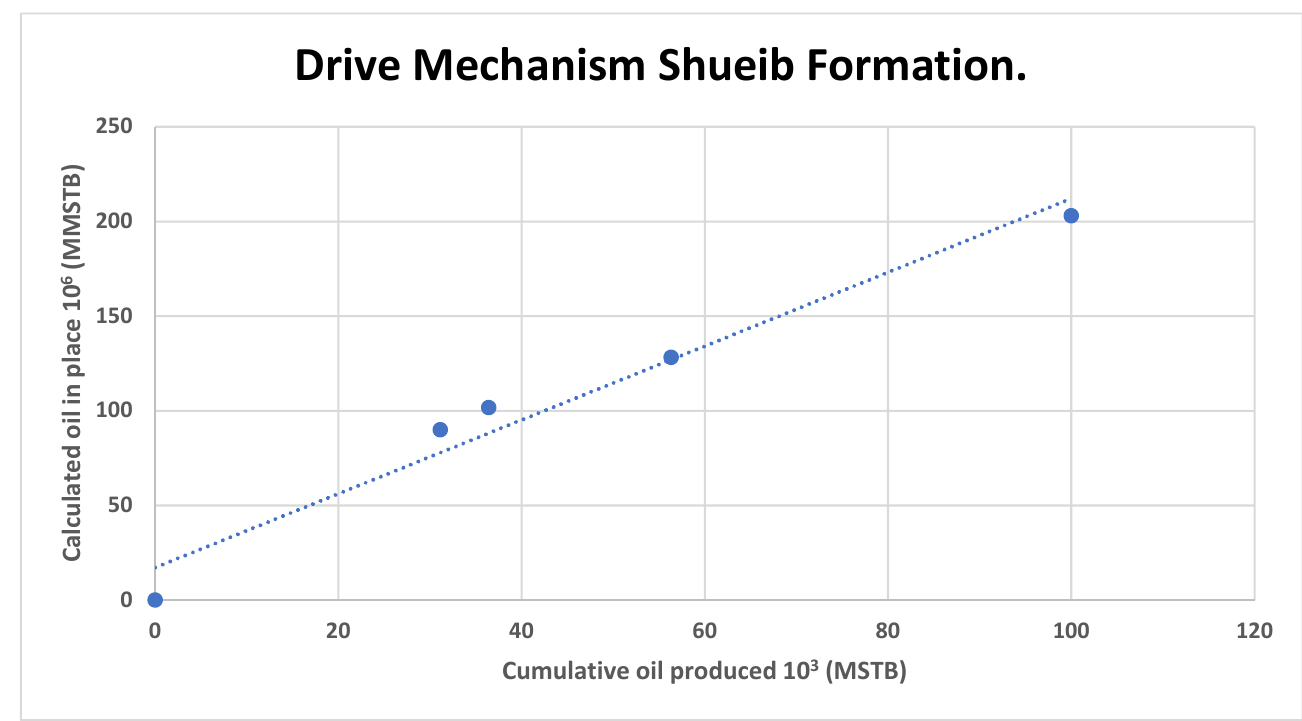
Figure 2. Calculated oil in place vs. cumulative oil production in the Shueib formation.